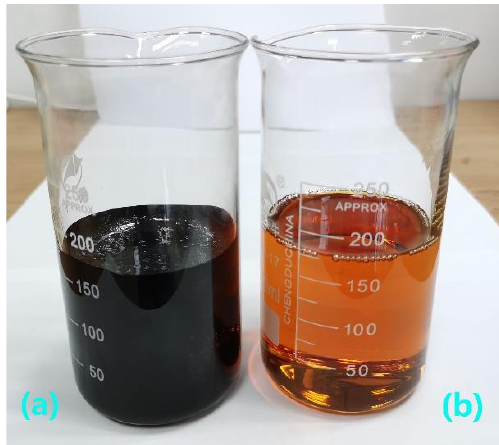
Figure 11. ( a ) Asphalt rubber binder and ( b ) waste cooking oil used in this study. Table 7. Physical property of the epoxy resin for preparing epoxy asphalt binder.